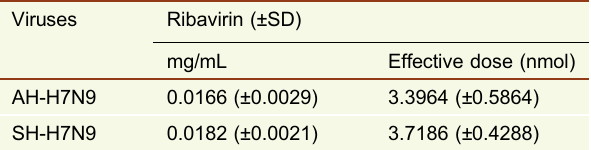
Table 1. EC 50 values of ribavirin against H7N9 virus Viruses